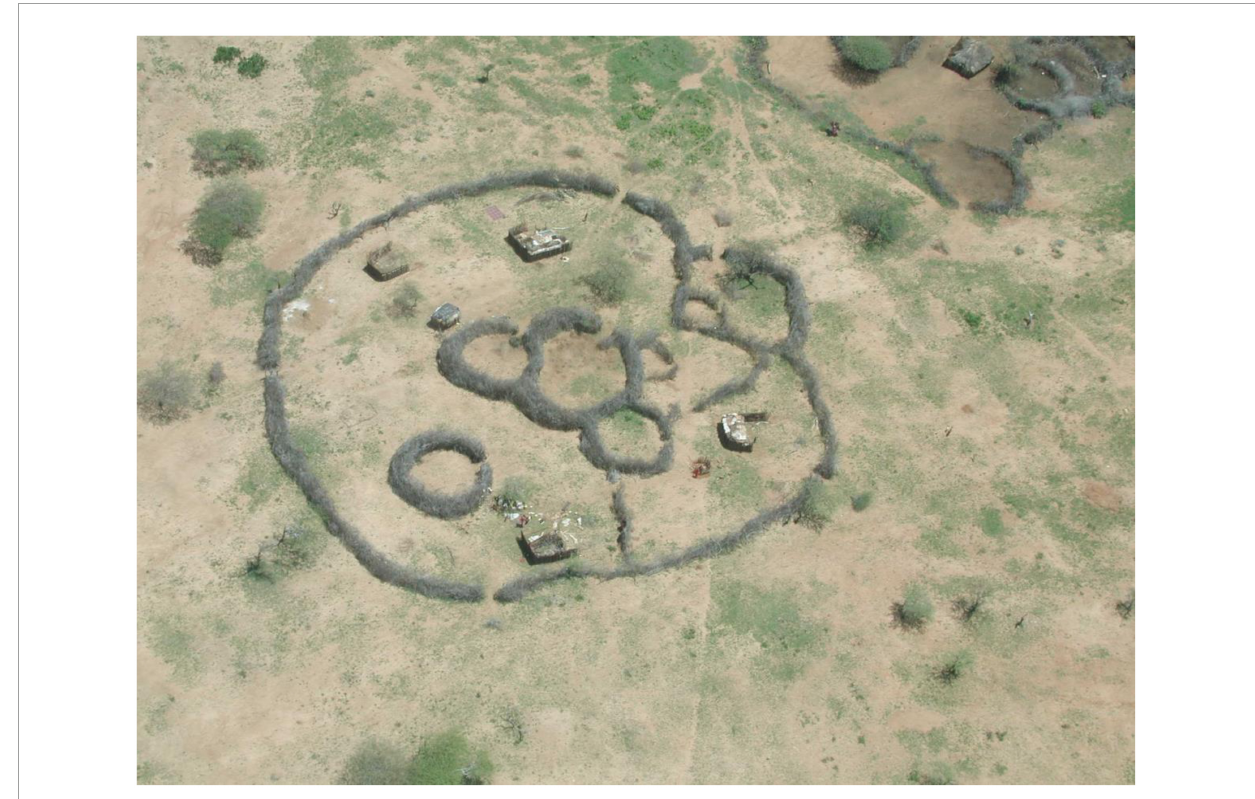
FIGURE2 Traditional Maasai manyatta, showing outer fence of thorn bush surrounding smaller internal bomas and dwellings. A thorn boma on a commercial ranch in Laikipia was a single unit, often divided into “rooms,” with herder dwellings outside the perimeter.